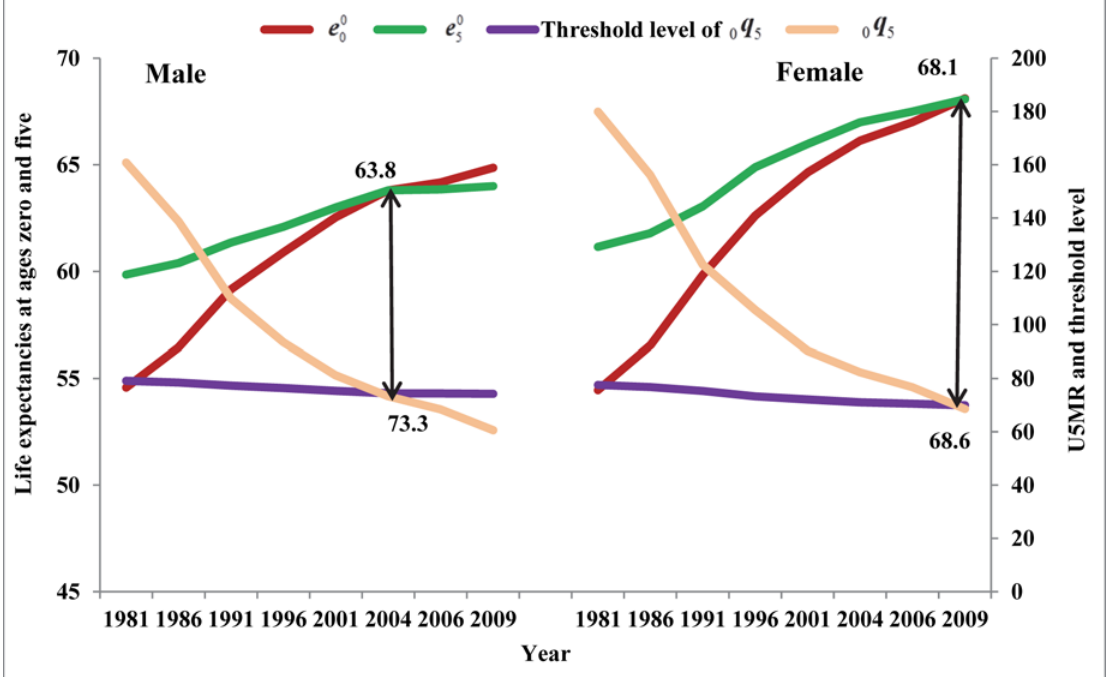
Fig 1. Life expectancies at ages zero and five, under-five mortality rate (U5MR) and threshold level of U5MR required for crossover, India, 1981 –